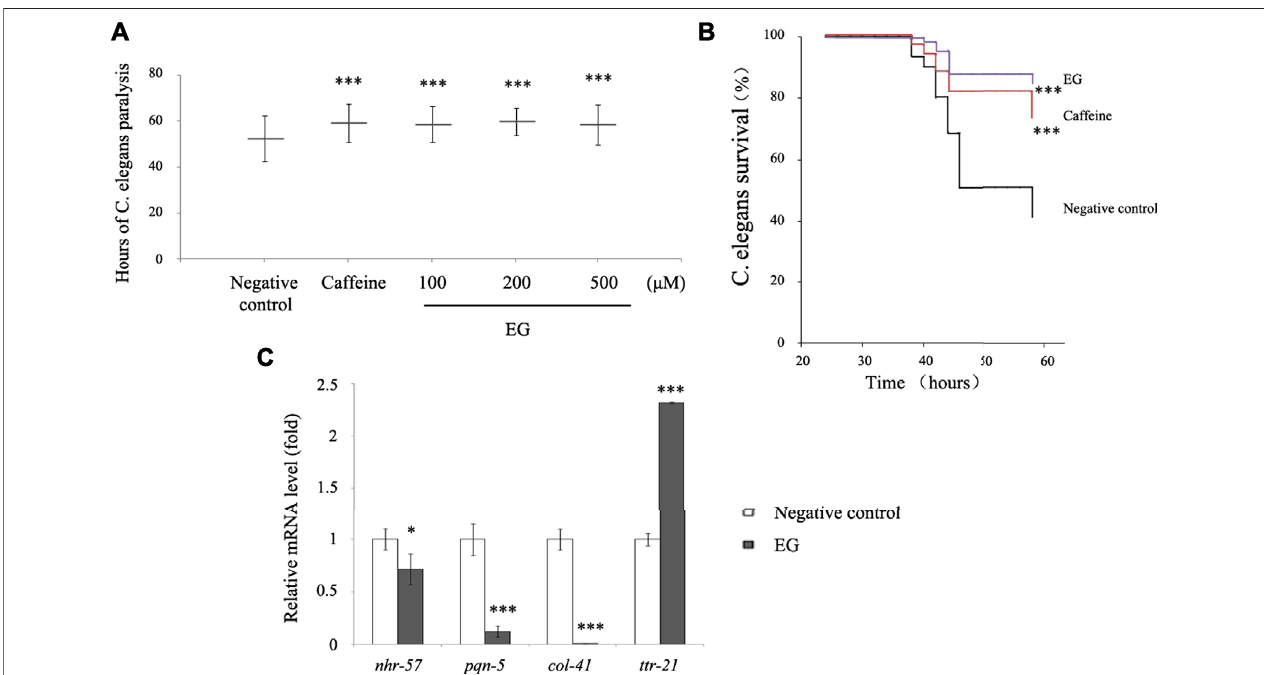
FIGURE 8 | EG retarded transgenic C. elegans paralysis in AD model. (A) . CL14176 of C. elegans strain synchronized to L1 phase, and cultured at 16 ° C for 24 h, thentransferredto25 ° Ctoexpressamyloidpeptidesthatwouldresultinparalysis.Thenegativecontrolwasuntreated(equalvolumeofwater),thepositivewasexposed to6.27 mMcaffeine,andtheEGwasmeasured.Themeanparalysistimes andtheranksoftheindividualparalysis times ineachgroup areshown(see Supplementary Table S1 ). Asterisks indicate statistical signi fi cance (*** p << 0.001). (B) Worms were synchronized and cultured at 16 ° C for 24 h, then transferred to 25 ° C for activation.Theparalysisphenotypesweredetectedafter38 h,thenumberofwormsnotparalyzedwasconverted toapercentage,andthe “ non-paralyzed ” percentage wasplotted against time activation initiation. The negativecontrol was untreated as described above, the positive wasexposed to6.27 mM caffeine, and the test group to200 μ M EG.Asterisksindicatestatisticalsigni fi cance(*** p << 0.001). (C) TotalRNAoftheuntreatedandEG(200 μ M)groupswasextractedandreversetranscribedto cDNA. The mRNA levels of nhr-57, pqn-5, col-41, and ttr-21 were measured using quantitative RT-PCR. An asterisk indicates statistical signi fi cance (* p < 0.05, ** p < 0.001, *** p << 0.001). EG: emodin-8-O- β - D